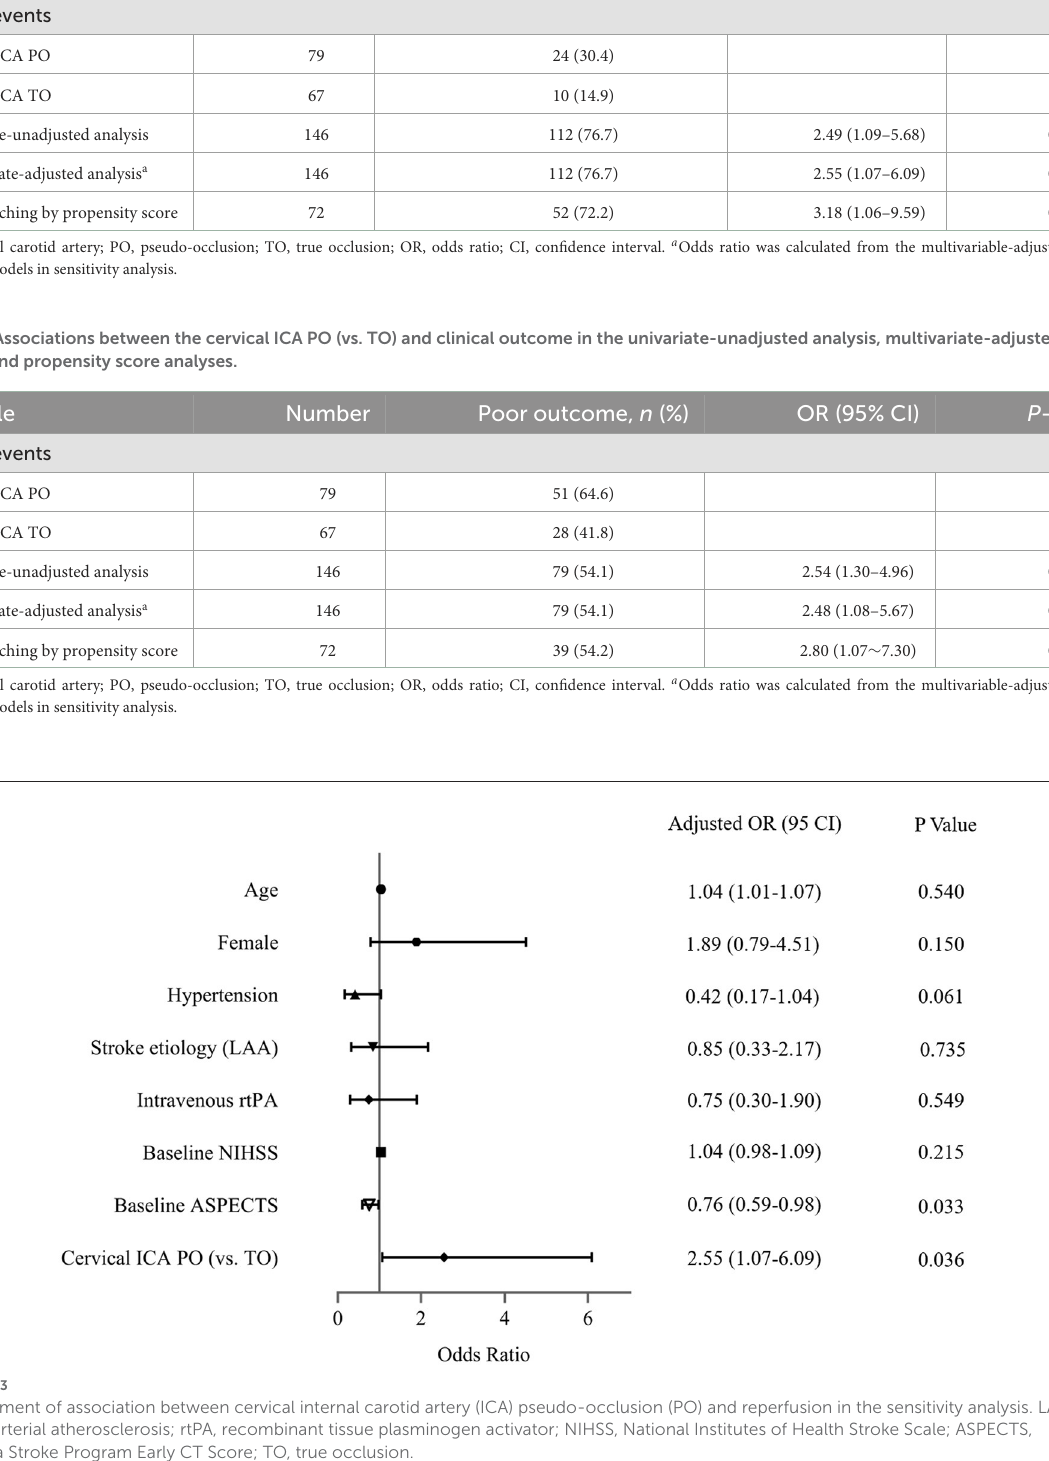
TABLE 2 Associations between the cervical ICA PO (vs. TO) and reperfusion in the univariate-unadjusted analysis, multivariate-adjusted analysis, and propensity score analyses. Variable